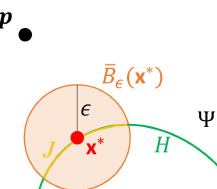
Figure 5. A schematic diagram of the flashlight-searching (FS) algorithm, where p is a point in R d , d ≥ 2, H is the set of points satisfying Ψ = 0, x ∗ is the point such that d ( p , x ∗ ) = d ( p , H ) , B (cid:101) ( x ∗ ) = { x : || x − x ∗ || ≤ (cid:101) } denotes a closed ball of radius (cid:101) > 0 centered at an x ∗ , and J = B (cid:101) ( x ∗ ) (cid:84) H denotes the arc of H associated with B (cid:101) ( x ∗ )